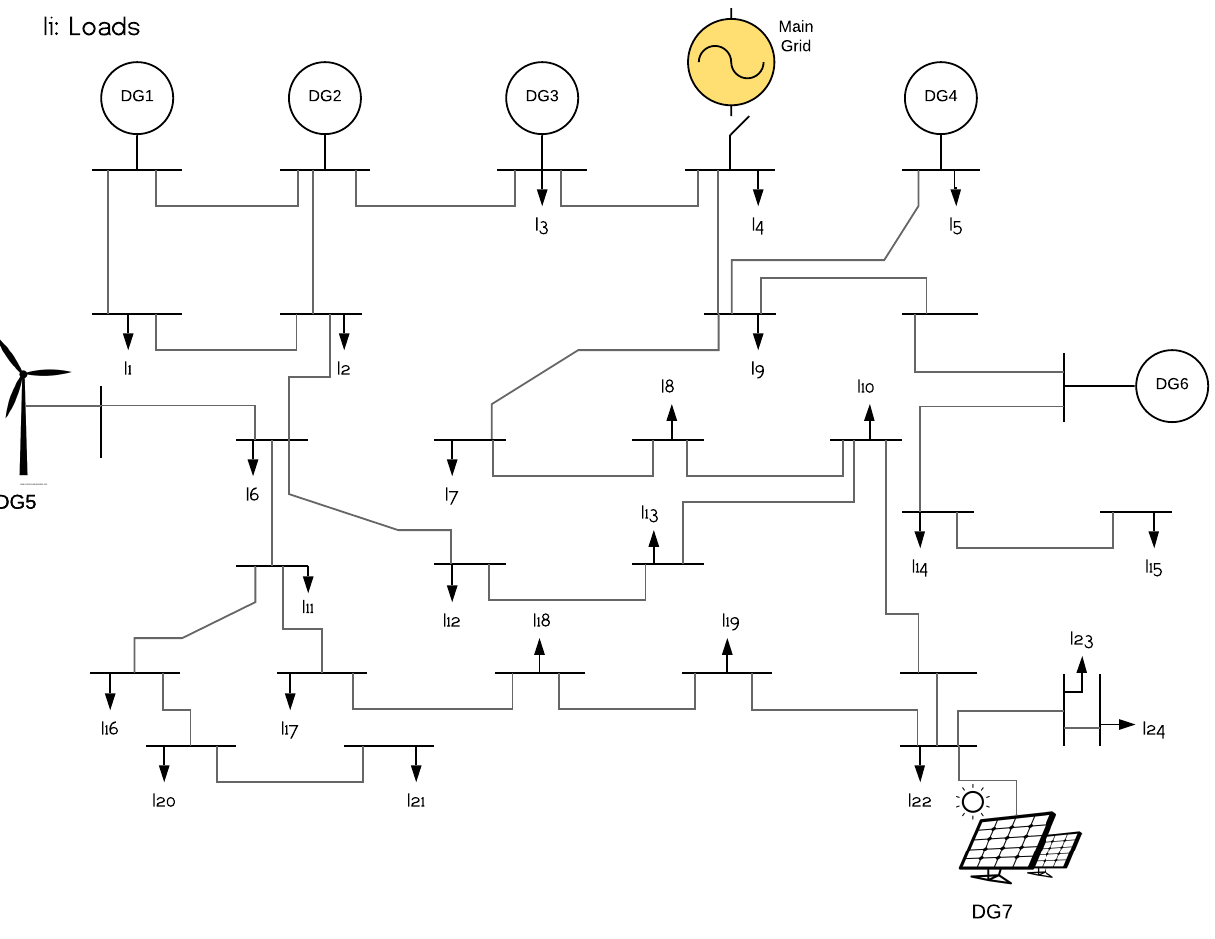
Figure 4. Microgrid distribution. Adapted from